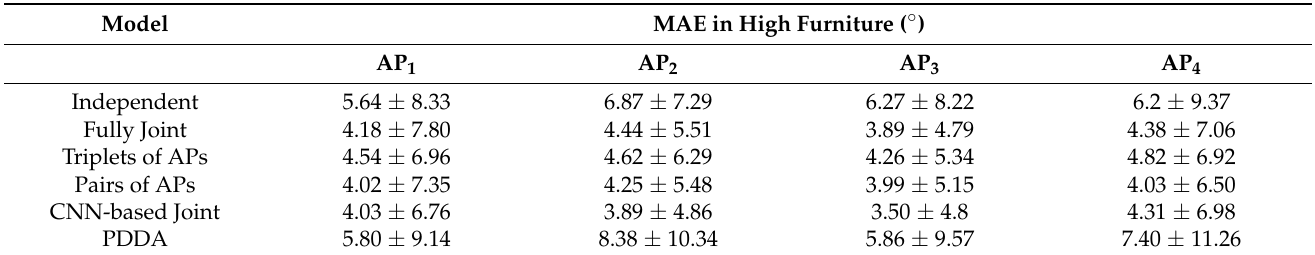
Table 2. Comparison of each model’s AoA MAE when evaluating in a single room